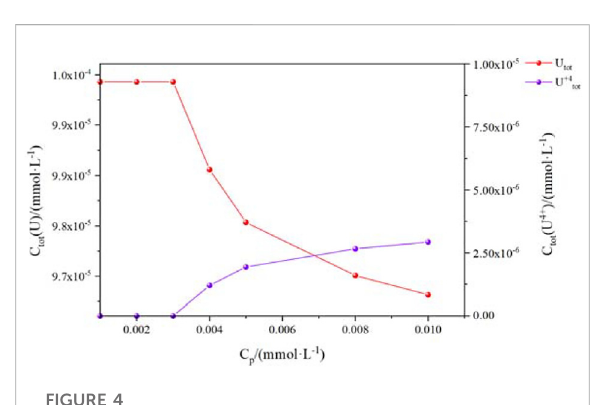
FIGURE 4 Concentration of U tot and U (+4) tot as functions of pyrite